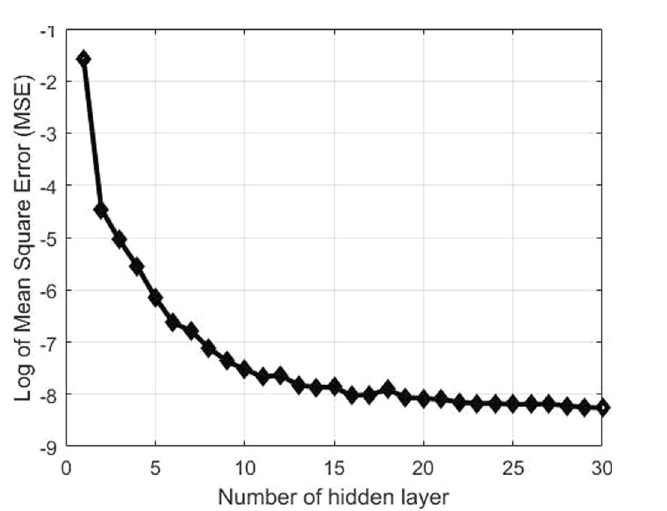
Figure 3. Dimensional functions Π 3 , and Π 4 for conventional nanoindentation.